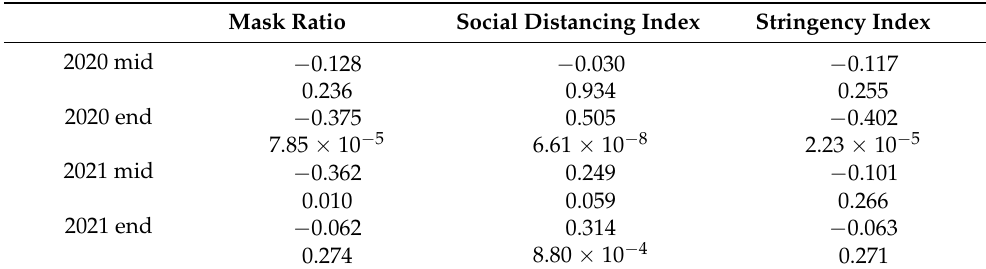
Table 1. Spearman’s simple correlations between influenza detection ratio and each control measure. Upper: correlation coefficient (rho), Lower: ( p values). Mask Ratio